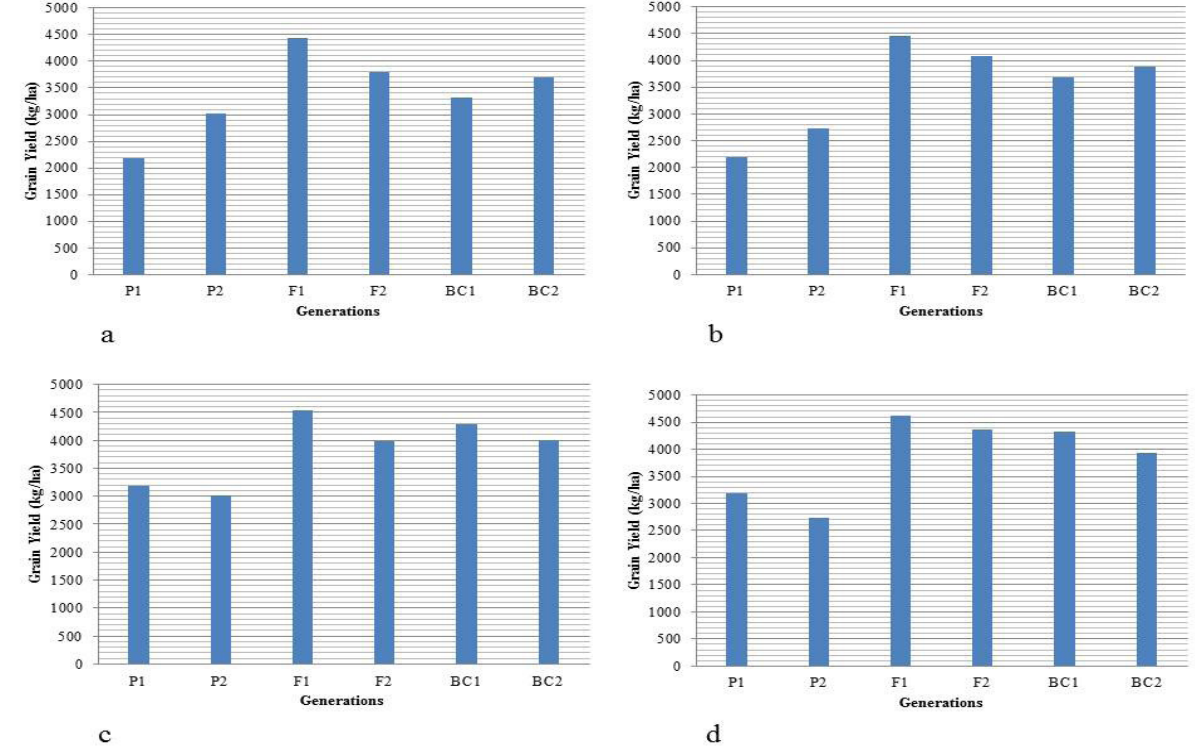
Figure 1: Mean grain yield (kg/ha) P1, P2, F1, F2, BC1 and BC2 in Cross-I (a), Cross-II (b), Cross-III (c) and Cross-IV